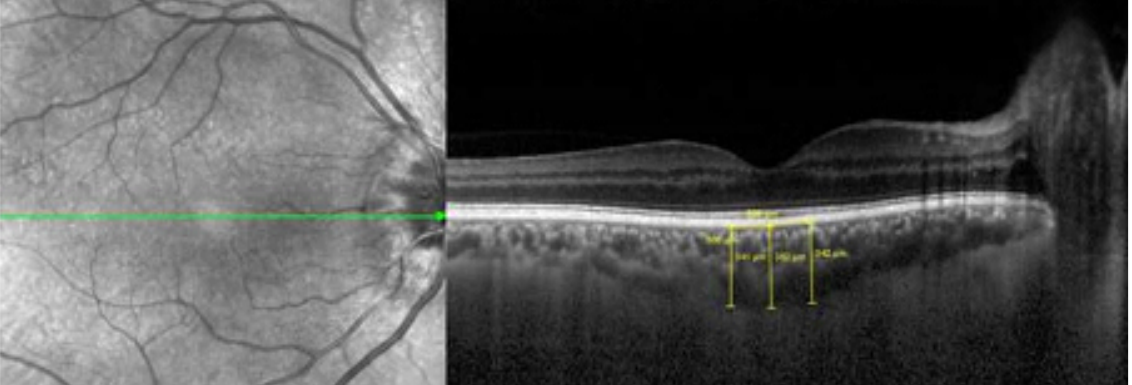
Figure 2. Choroidal thickness at the center of the fovea and 500 𝜇 m from the center at temporal and nasal